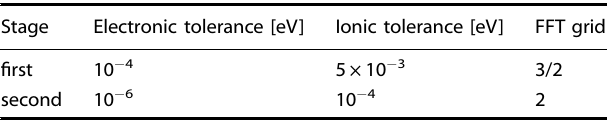
Table 1. Settings for the automatic work fl ows. Stage Electronic tolerance [eV]